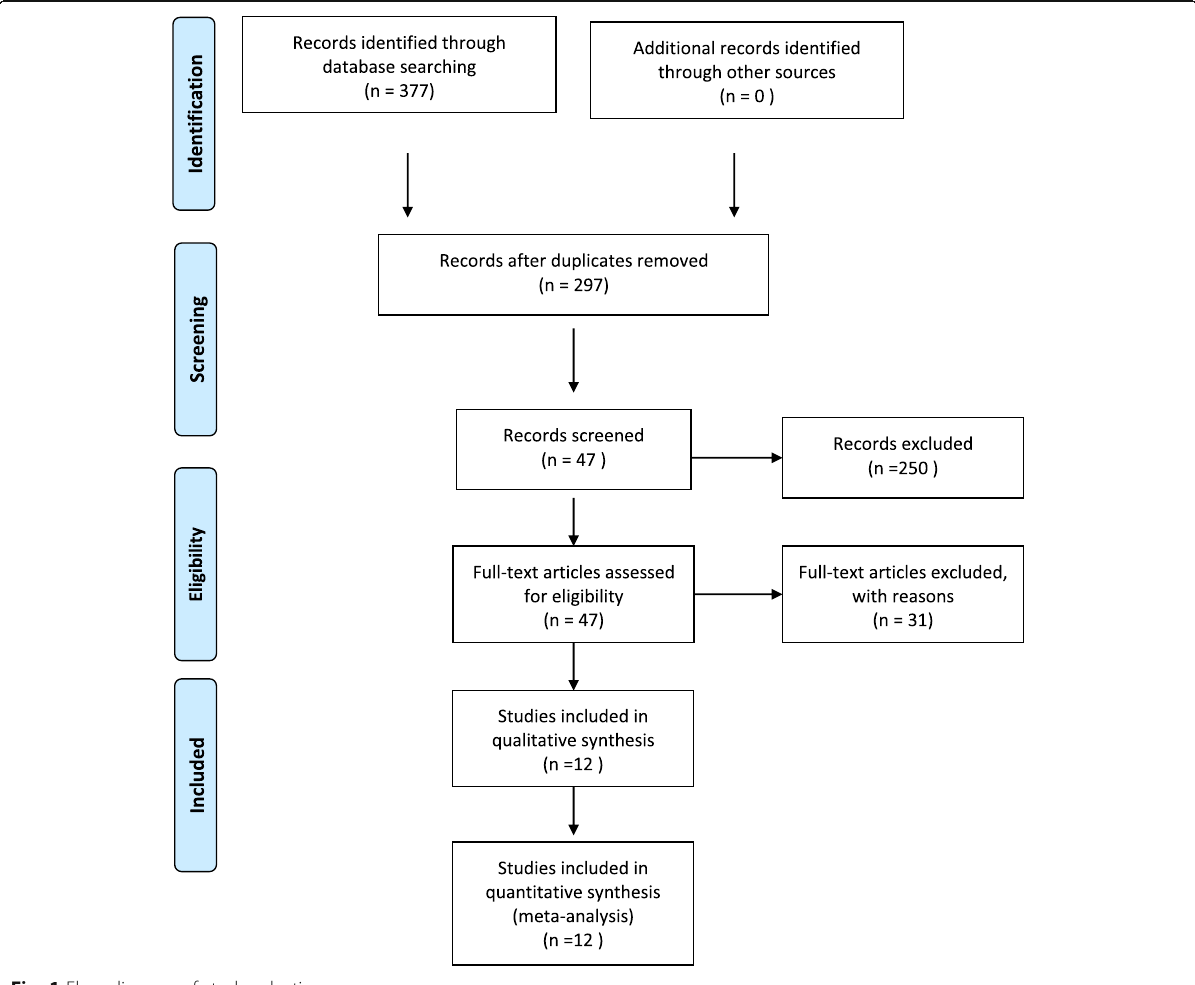
Fig. 1 Flow diagram of study